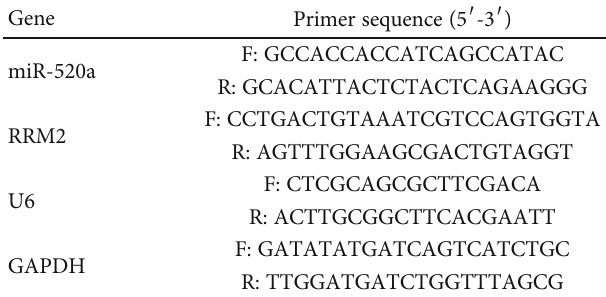
Note: RT-qPCR: reverse transcription quantitative polymerase chain reaction; RRM2: ribonucleotide reductase subunit 2; GAPDH: glyceraldehyde-3- phosphate dehydrogenase; F: forward; R: